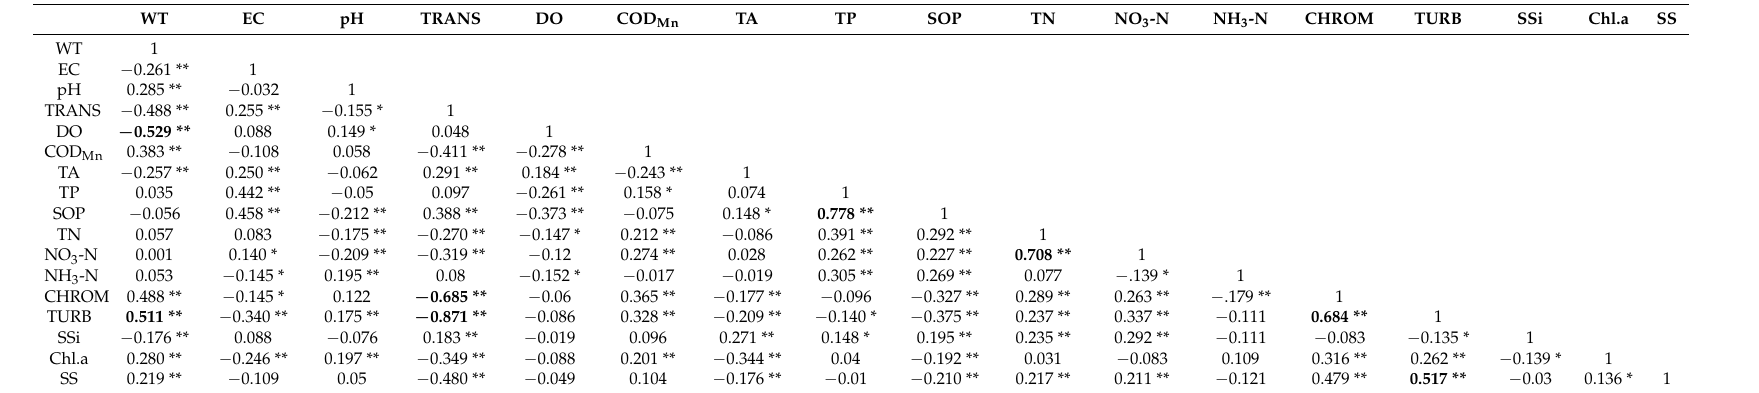
Table 2. Spearman correlation coefficient matrix of water environment variables sampled from LRB,